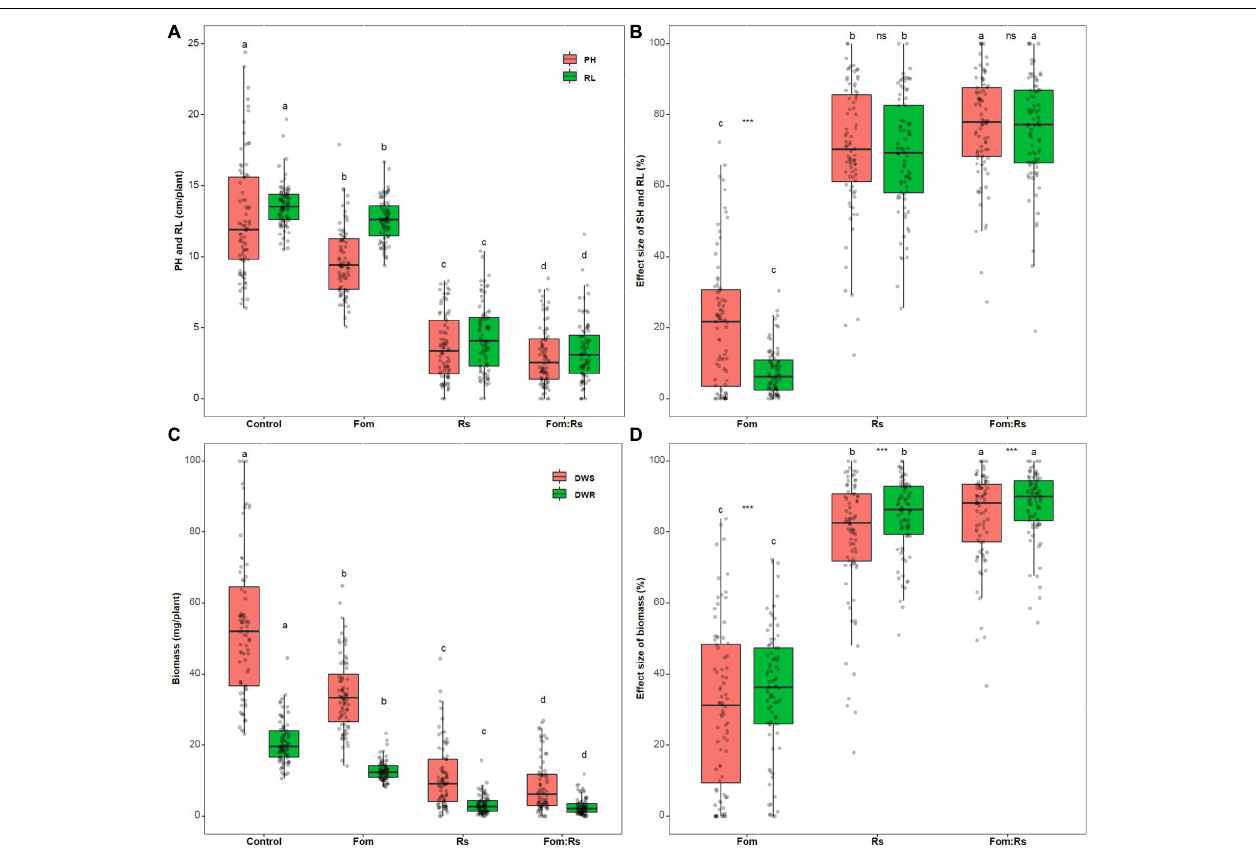
FIGURE 2 | Pathogen effects on plant growth among 80 alfalfa varieties single or co-inoculated with Fom and Rs. (A) Variations in plant height (PH) and root length (RL), (B) effect sizes of PH and RL, (C) variations in dry weight of shoot (DWS) and root (DWR), and (D) effect sizes of DWS and DWR. Fom, single inoculation with Fom; Rs, single inoculation with Rs; Fom:Rs, co-inoculation with Fom and Rs. Boxplots show the medians and 25th and 75th percentiles, with whiskers extending to 1.5 times of the interquartile range, and data presented beyond whiskers represent outliers. Different letters above the bars in the same column indicate significant differences ( p < 0.001) among treatments according to Fisher’s protected LSD test. Asterisks between the bars under the same treatment indicate a significant difference ( p < 0.001) between traits by Student’s t -test. ns, not significant between traits. Three values of DWS larger than 100 (115.1, 145.9, and 119.6 mg/plant for Mvv16, Msv17, and Msv27, respectively) under the control treatment were defined as 100 to maximize resolution. Positive effects (effect size < 0) of pathogen treatment on some traits under Fo ( Supplementary Figure 2 ) were defined as zero to maximize